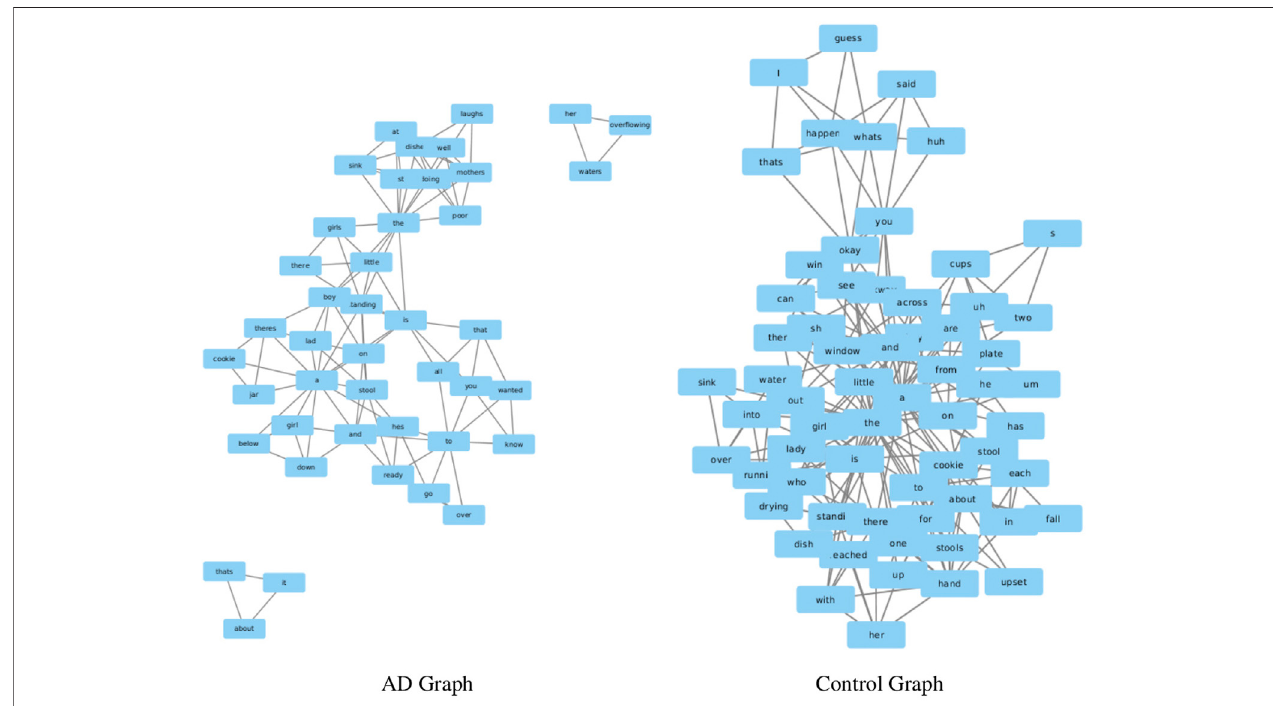
FIGURE 1 | Example